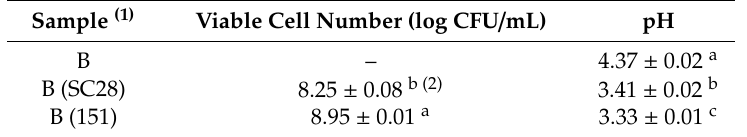
Table 4. Viable cell number and pH value of non-fermented and fermented black gamju.